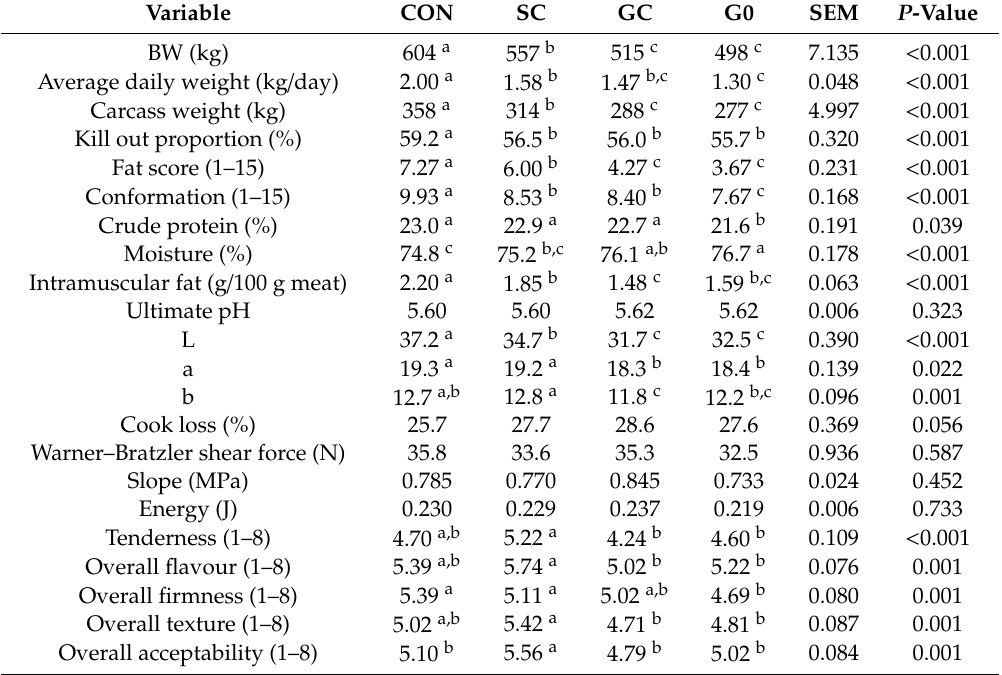
Table 2. Animal performance and characteristics of longissimus thoracis muscle from bulls assigned to one of the following systems: grass silage plus barley-based concentrate ad libitum (CON); grass silage ad libitum plus 5 kg of concentrate (SC); grazed grass without supplementation (G0) or grazed grass plus 0.5 kg of the dietary dry matter intake as concentrate (GC) until slaughter at 15